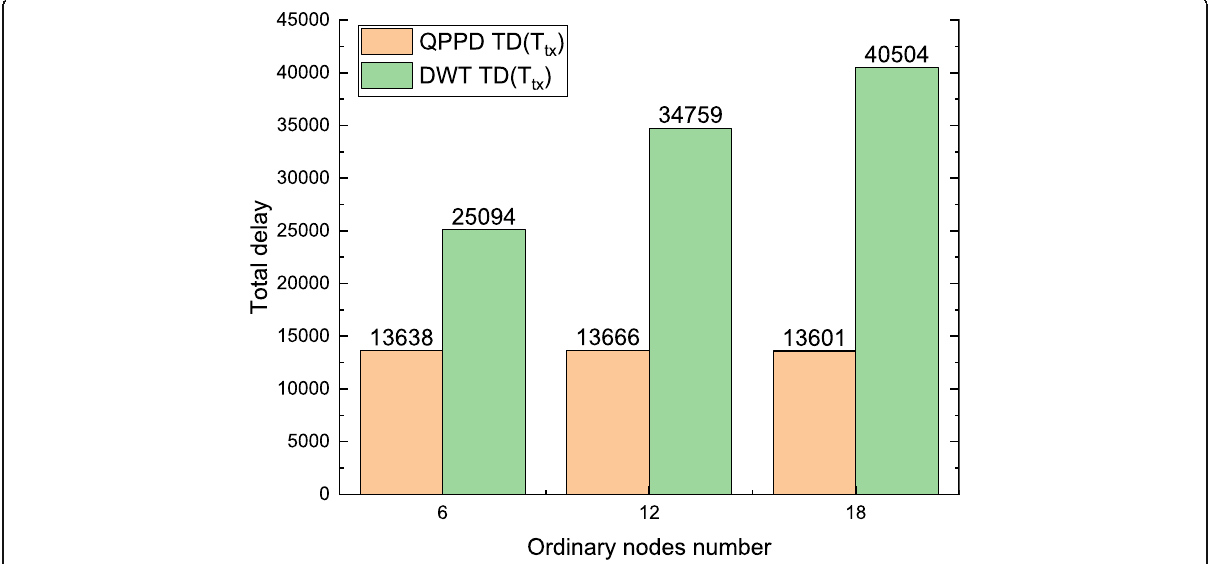
Fig. 42 The total volume of data randomly changes from 0 to 18; the total